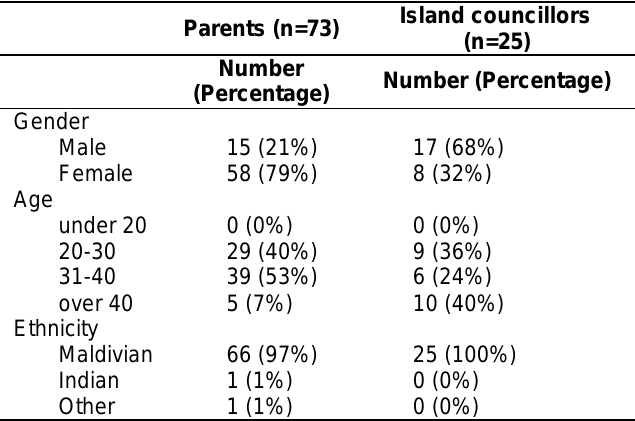
Table 1. Characteristics of Parents and Island